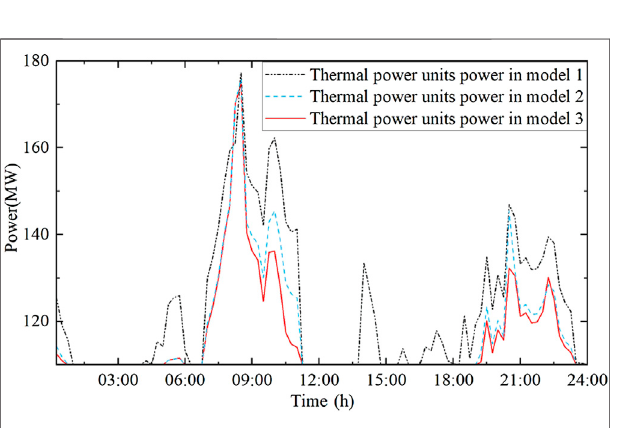
FIGURE 7 | Scheduling model power comparison diagram of thermal power units.